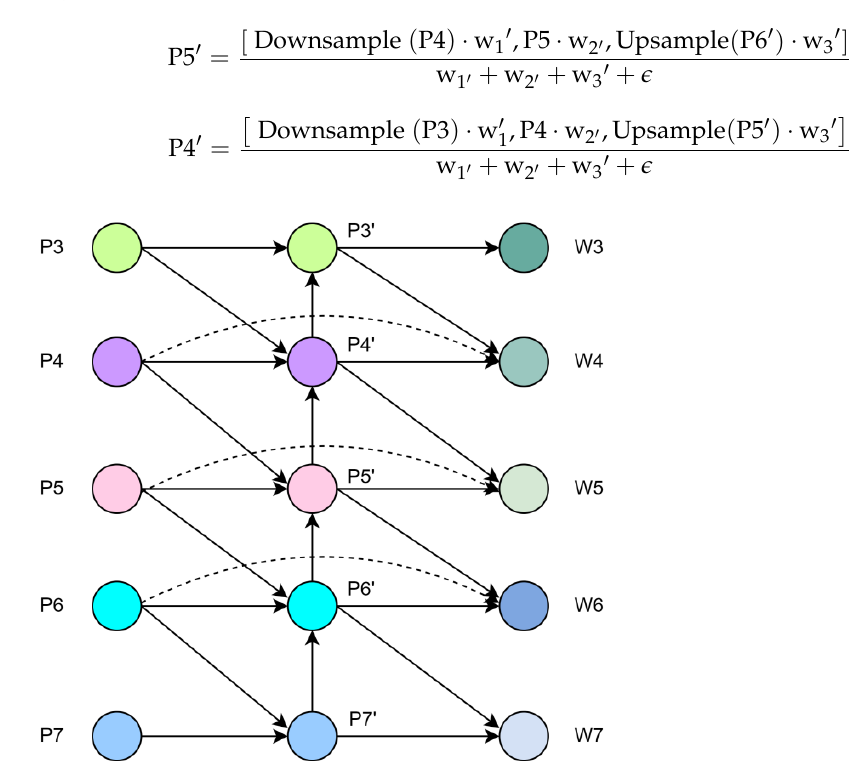
Figure 5. DBiFPN, fusing more detailed information in the feature map using the more shallow feature map P3 (160, 160), fusing more feature information using cross-layer